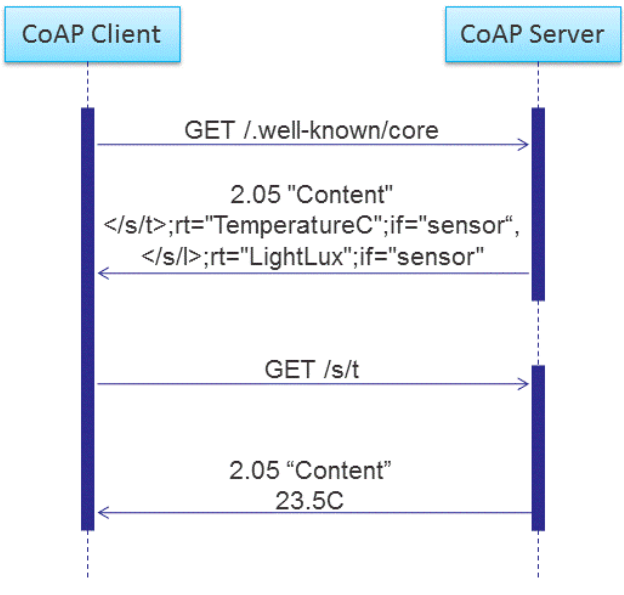
Figure 15. An example of Constrained RESTful Environments (CoRE) resource discovery and Constrained Application Protocol (CoAP)